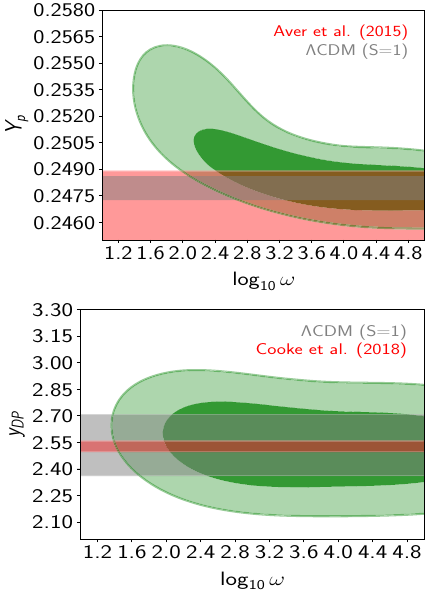
Fig. 6 The 2D constraints on the BBN predicted 4 He (helium) mass fraction Y p (top panel) and D (deuterium) y DP mass fraction (bottom panel) in BD gravity are plotted with 1 σ (dark green) and 2 σ (light green) confidence contours. Grey bands are for the SBBN-predicted mass fractions with 1 σ . Red bands are independent observational esti- mates with 1 σ from [157,158]